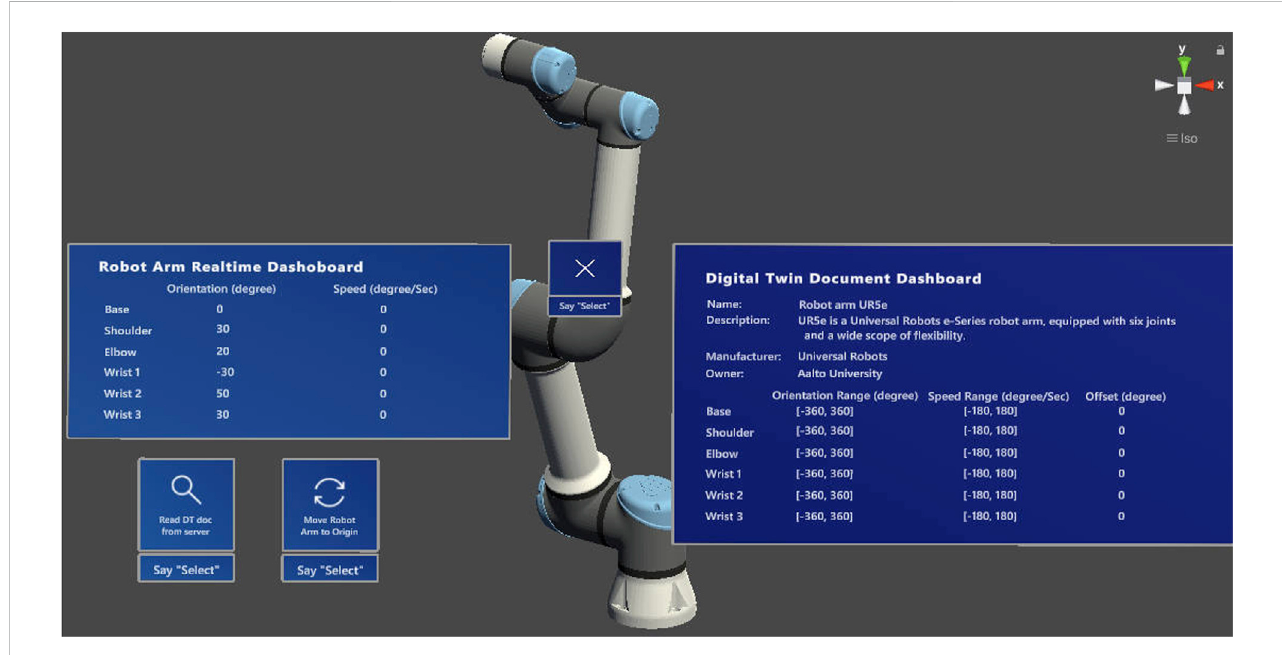
FIGURE 6 Screenshot of the implemented MR application “ HoloRobot ” (Unity developer view on